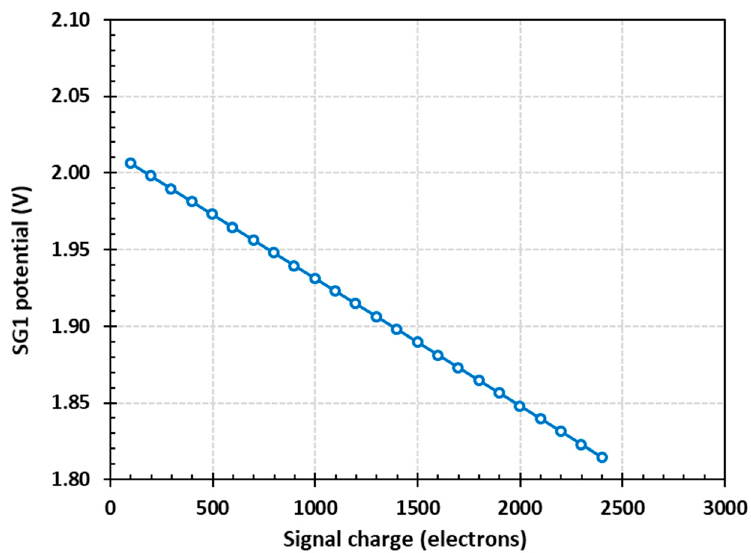
Figure 6. Simulated voltage on SG1 as a function of the amount of charge under SG1. The simulation is in 2D with a 1 ‐μ m depth in the third dimension corresponding to the BC width.